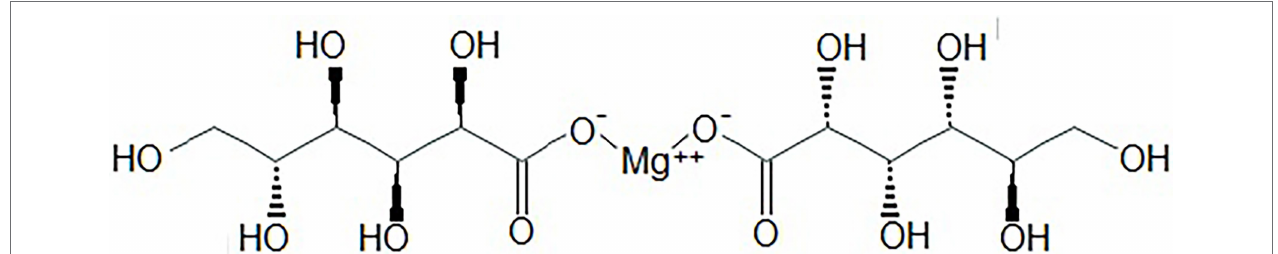
FIGURE 1 | Molecular structure of